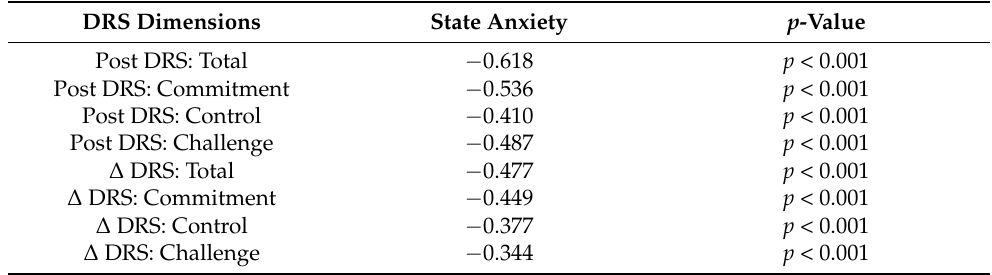
Table 18. Correlation between state anxiety and the DRS scale of nurses caring for COVID-19 patients. DRS